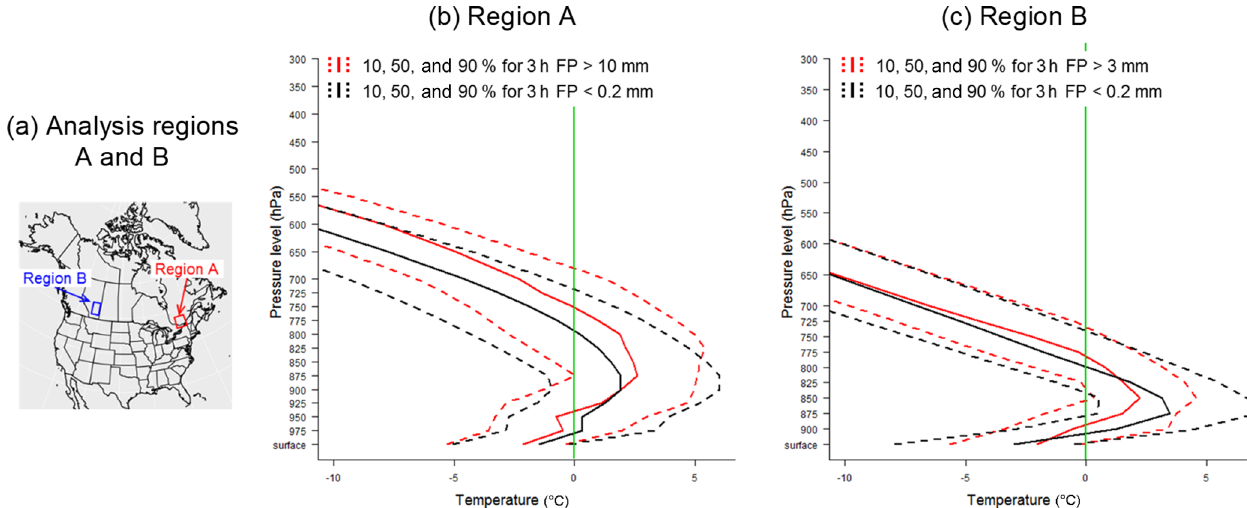
Figure 3. Distributions (10th, 50th and 90th percentiles) of vertical temperature profiles during heavy and light FP, obtained by the offline Bourgouin algorithm with 11 NARR vertical levels (i.e., case 1 in Fig. 2) at two selected analysis regions located in eastern and western North America for the baseline period. Different thresholds of heavy freezing precipitation (10 and 3mm) are used for the regions A and B by considering their wet and dry